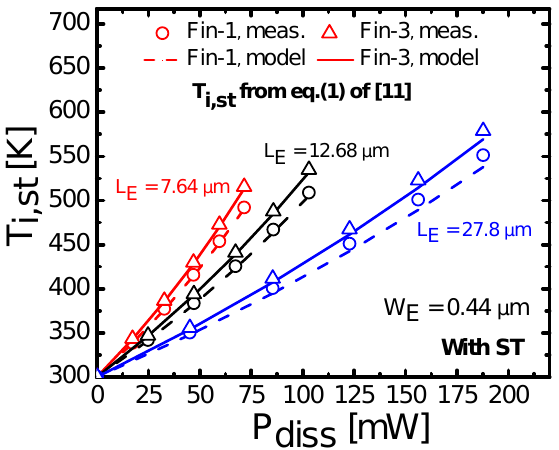
Figure 10. P diss —dependent total junction temperature T i , st of 1st and 3rd finger in a five-finger structure with shallow trench (ST), T i , st is obtained after substituting values of ∆ T jj , st and c ij , st in Equation (1) of [11]. Symbols are obtained after substituting measurement data ([22]) while the solid and dash lines results after inserting self-heating and thermal coupling model values in the